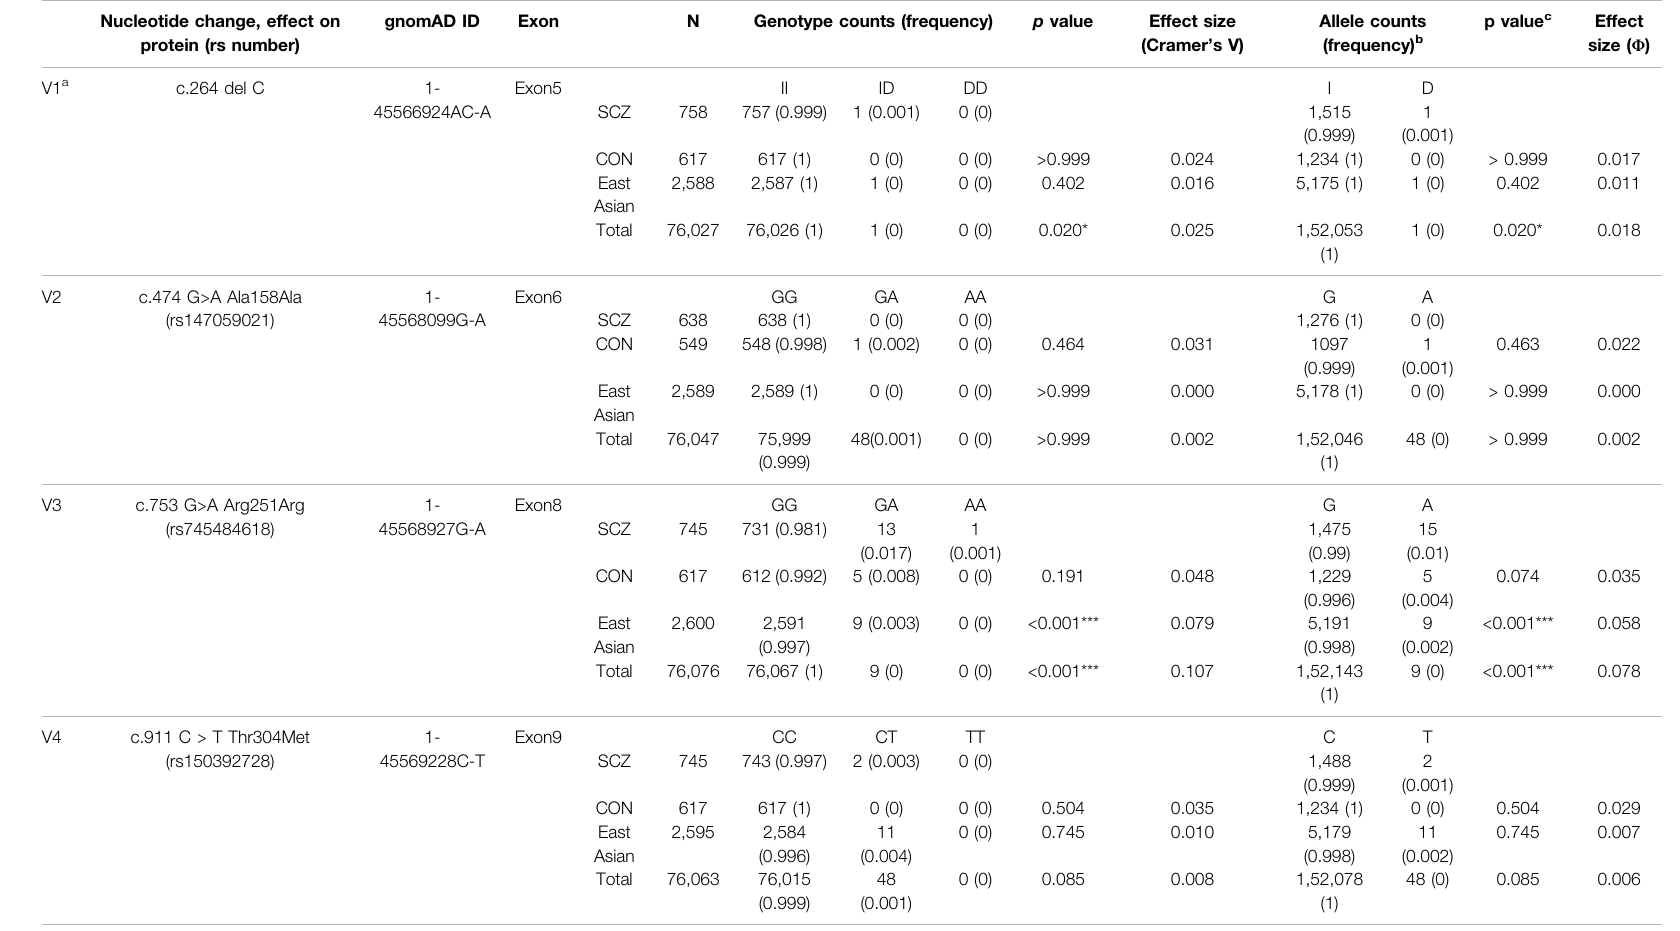
a The variants detected in the coding region are described using gene region, genotype counts, and allele counts. b Allele frequencies of East Asian and Total groups (including African/African-American, Amish, Ashkenazi Jewish, East Asian, Finnish, non-Finnish European, Latino/Admixed American, Middle Eastern, Other, and South Asian) based on Genome Aggregation Database (gnomAD) were also used as controls. GRCh38 was used as a reference genome. c The chi-squared test was used for statistical analysis when all cells had an expected value of more than 5. Fisher ’ s exact test was used when one or more cells had an expected value of 5 or less. * p < 0.05, *** p < 0.001 versus